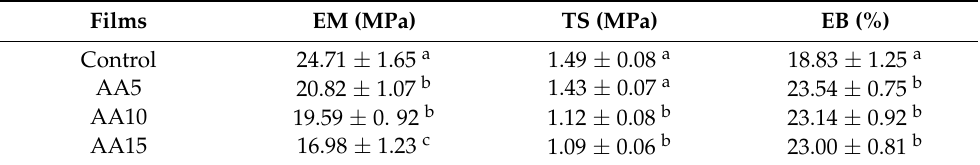
Table 5. Elastic modulus (EM), tensile strength (TS), and elongation at break (EB) of WPI films as a function of AA content.